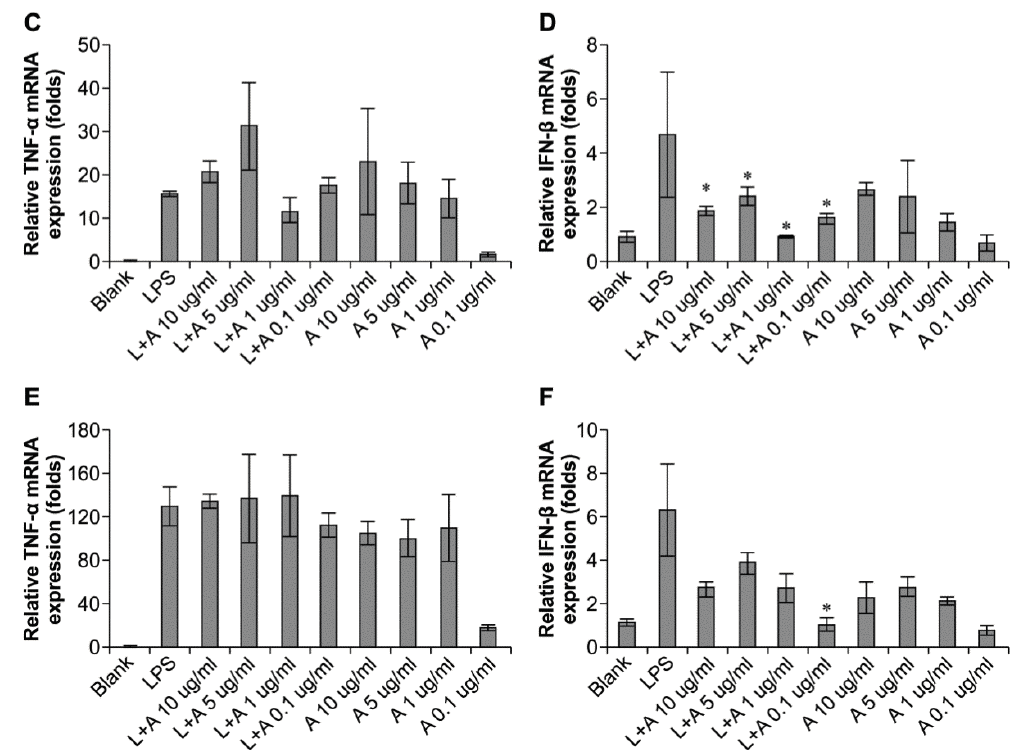
Figure 3. Concentration of humanized anti-TLR4 antibody Fab with effective inhibitory effect on lipopolysaccharides (LPS)-stimulated macrophages. ( A , B ) Effects of different concentration of the antibody on inhibition of TNF- α ( A ) and IFN- β ( B ) expression induced by LPS (1 µg/mL) in mouse macrophages; ( C , D ) Effects of different concentration of the antibody on inhibition of TNF- α ( C ) and IFN- β ( D ) expression induced by LPS (100 ng/mL) in mouse macrophages; ( E , F ) Effects of different concentration of the antibody on inhibition of TNF- α ( E ) and IFN- β ( F ) expression induced by LPS (10 ng/mL) in mouse macrophages. The expressions of TNF- α , IFN- β were measured by Q-PCR. L: LPS; A: humanized anti-TLR4 antibody. Data are shown as mean ± SD of pooled results of three independent experiments (* p < 0.05 compared to LPS